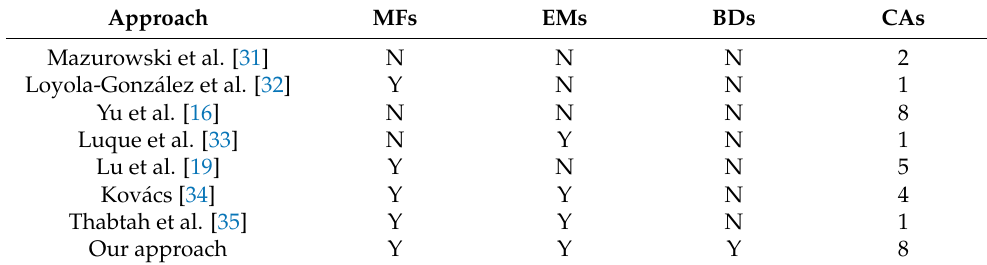
Table 4. A comparative summary of previous efforts in this